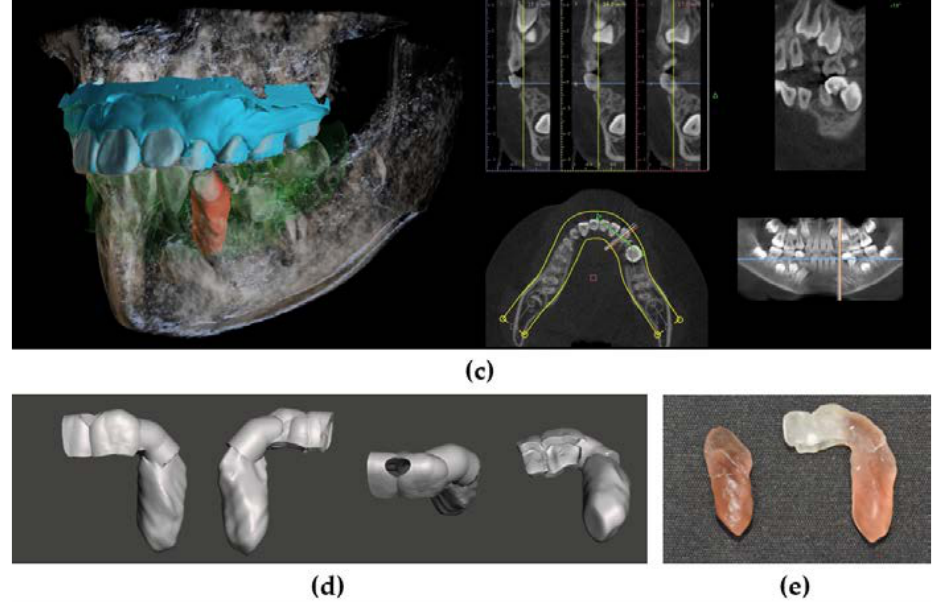
Figure 1. Fabrication procedure of surgical template. ( a ) Segmentation of the impacted canine; ( b ) merging of the cone-beam computed tomography and intraoral scan images; ( c ) virtual transplan- tation of the impacted canine to the ideal intra-arch position; ( d ) design of surgical template; and ( e ) 3D-printed canine replica and surgical template.